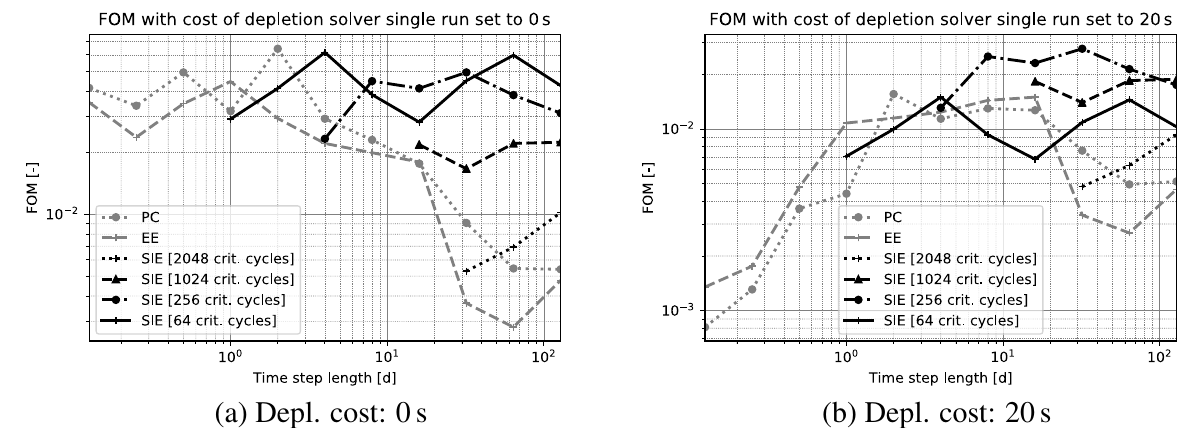
Figure 1: F OM vs time step length in simulations with two different costs of depletion